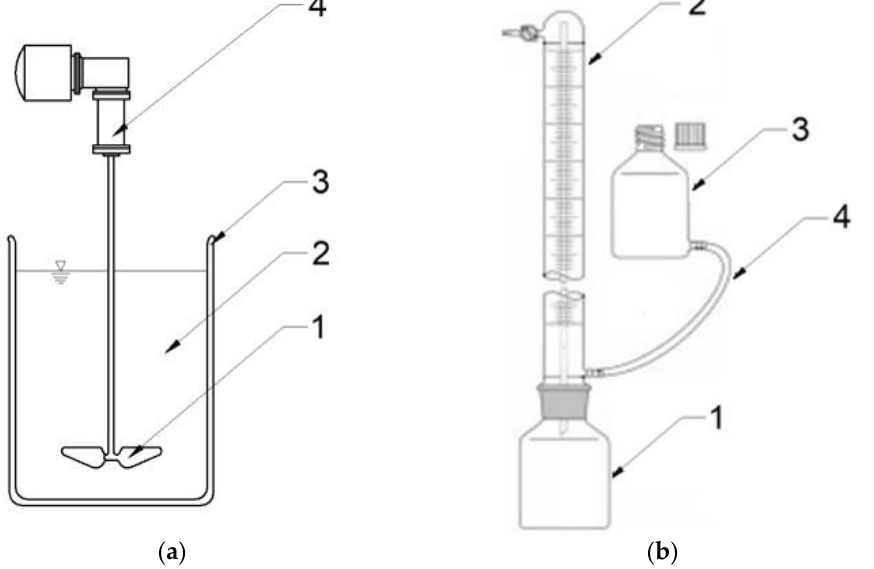
Figure 11. Schemes of research stations used in: ( a ) S1 (1 — mechanical agitator, 2 — AGS mixed with SCO 2 , 3 — glass reactor, 4 — drive); ( b ) S2 — scheme of an eudiometer (1 — reactor, 2 — burette with an internal glass tube for gas transport, 3 — pressure equalization tank, 3 — connecting tube).